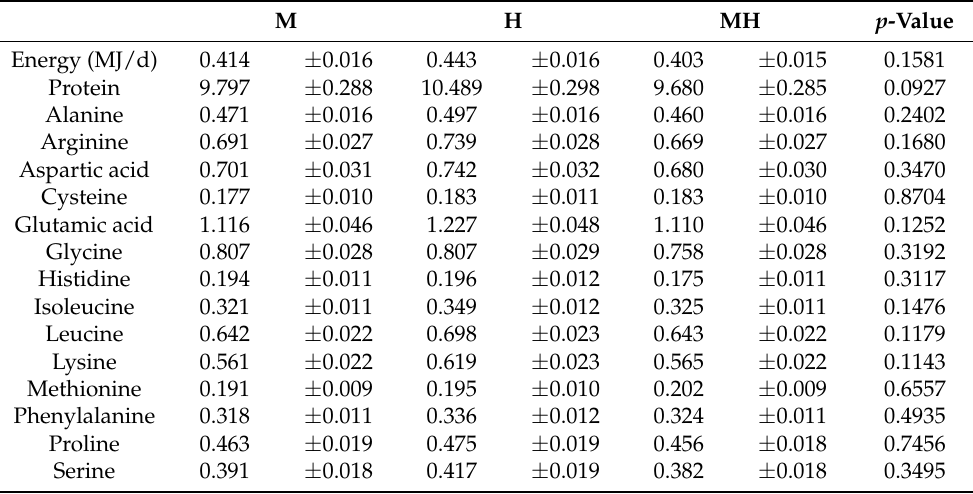
Table 5. Energy (MJ/d), protein (g/d) and amino acids (g/d) retained in the empty bodies of animals fed the experimental diets (M, H and MH) (n = 75) during the fattening period (average ± standard